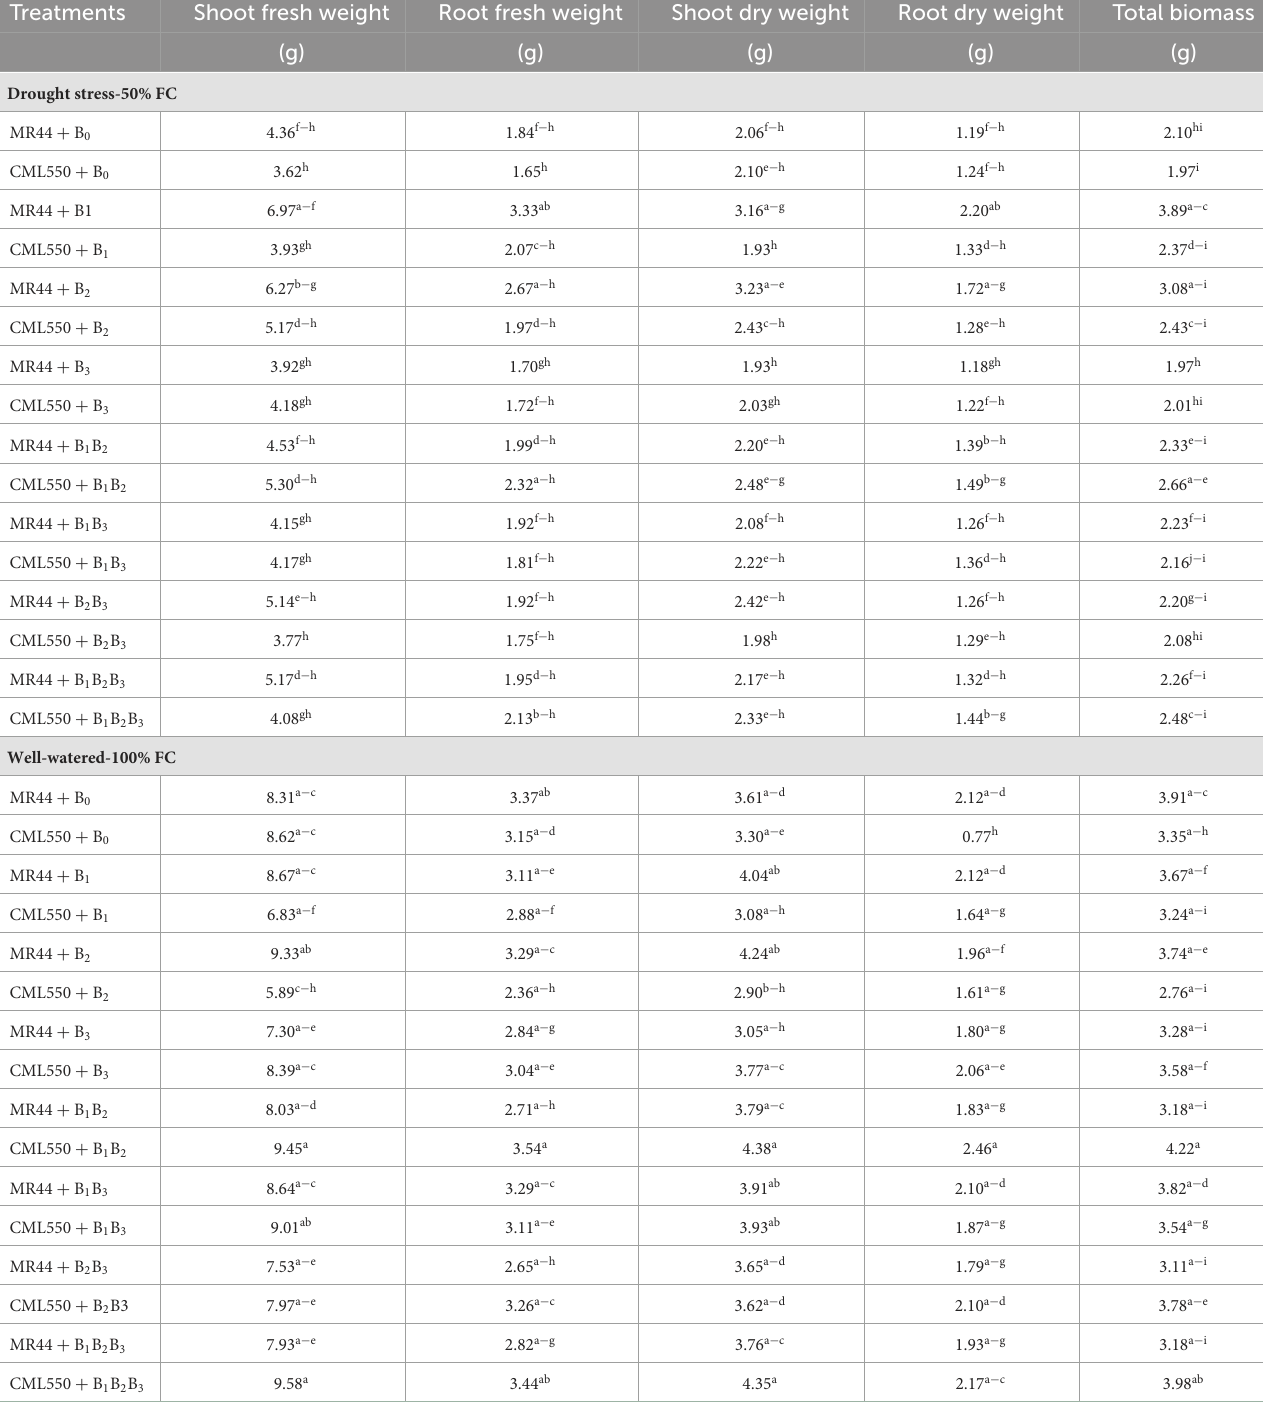
TABLE 4 Effect of treatments on biomass production of maize genotypes under drought stress (50% FC) and well-watered (100% FC) conditions. Treatments Shoot fresh weight Root fresh weight Shoot dry weight Root dry